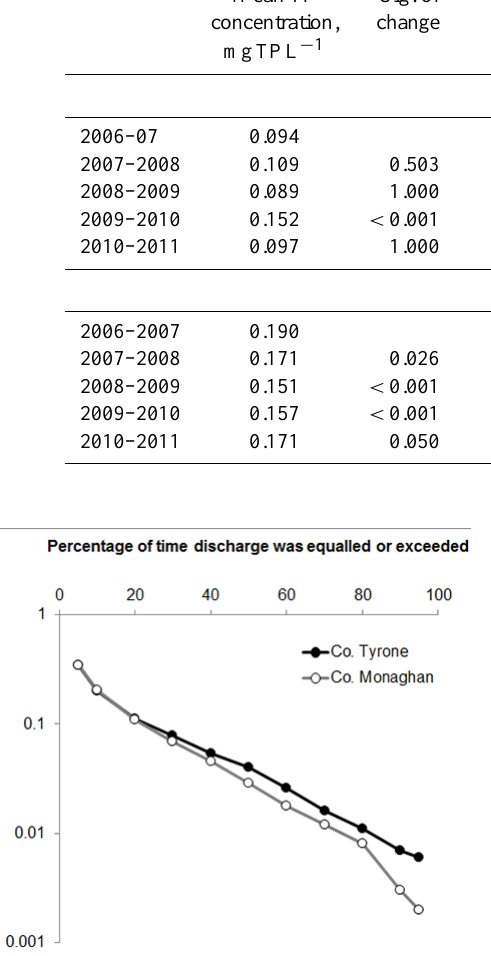
Figure 6. Flow duration curves for streams in Co. Tyrone (2006–